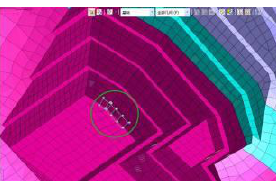
Figure 10. The position and area of loading.